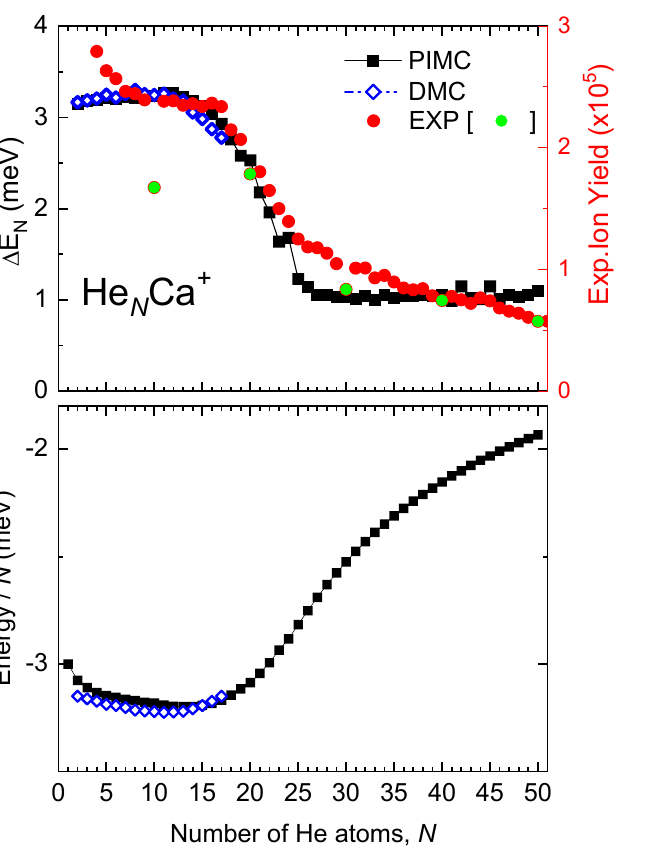
Figure 5. Upper panel: Evaporation energies ( ∆ E N = E N − 1 − E N ) for He N Ca + obtained with PIMC (black squares) and DMC (blue open diamonds) calculations are compared with experimental ion yields (red circles, except for N multiples of 10 which are shown in green, see text). Left and right y axes show the scales of the theoretical and experimental results, respectively. Lower panel: Energy per He atom ( E N / N ) obtained by the PIMC (black squares) and DMC (open blue diamonds)